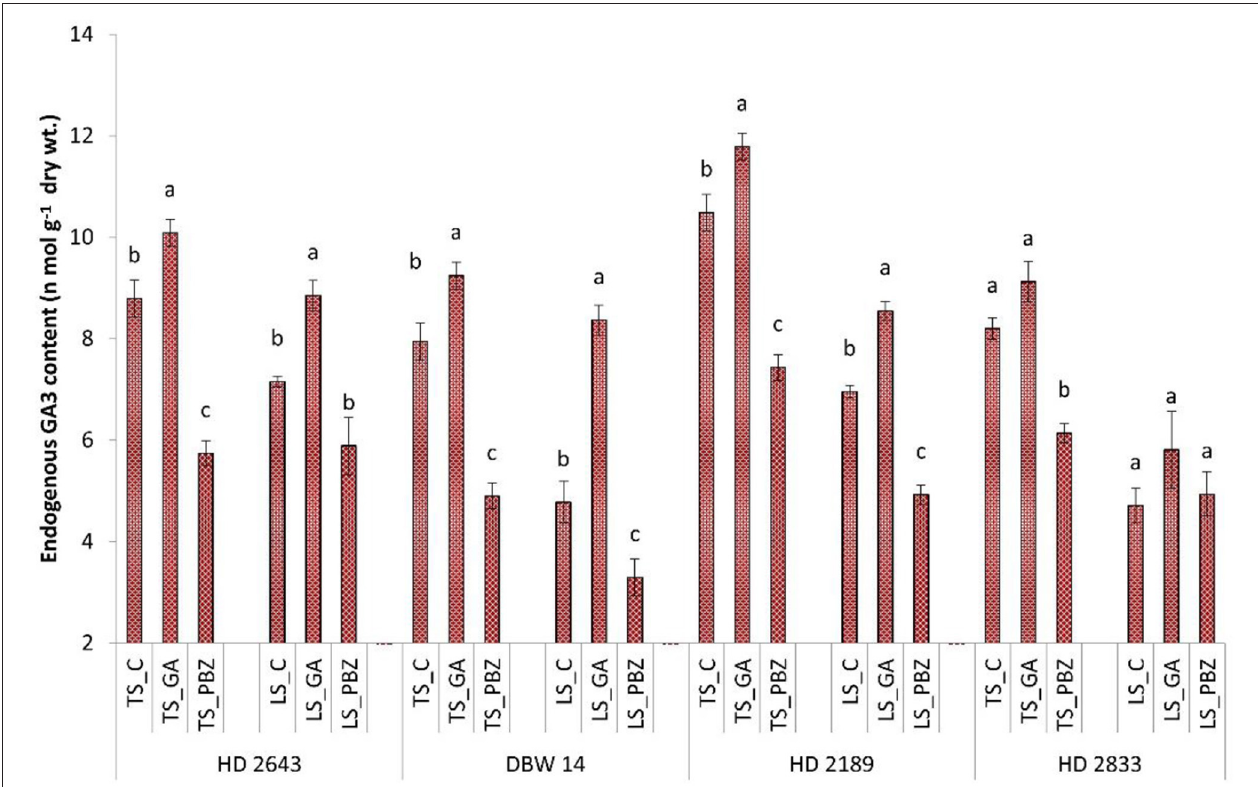
FIGURE 1 | Effect of post-anthesis application of gibberellic acid (100 ppm) and paclobutrazol (50 ppm) on endogenous GA 3 content (n mol g − 1 dry wt) in wheat exposed to timely and late sown conditions. The different letters on bar denotes significant difference among the treatments within the given variety and stress level according to LSD test at P < 0.05. The error bar represents the standard error. Value on the ordinate is the mean of five replicates. On the abscissa, HD 2643, DBW 14, HD2189, and HD 2833 are varieties; TS and LS denote timely sown and late sown of stress treatment, respectively; C, GA, and PBZ denote control, GA3, and paclobutrazol of spray treatment,